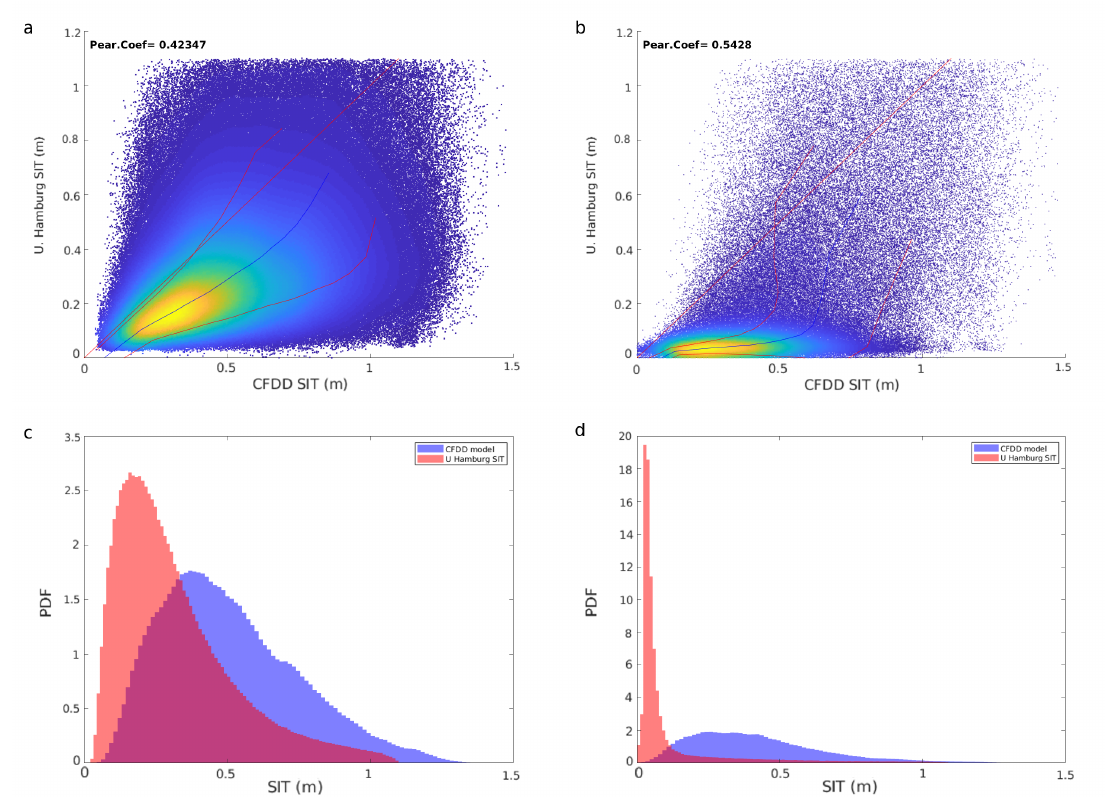
Figure 6. Comparison between the modeled CFDD SIT and the UH ice thickness. ( a ) SIC is between 70% and 90%. ( b ) SIC is between 30% and 50%. SMOS thickness uncertainty and saturation ratio are always below 1 m and 90% respectively. The mean and standard deviations are depicted with a blue and red lines respectively. ( c ) PDFs of CFDD and UH SIT for case a. ( d ) PDFs of CFDD and UH SIT for case